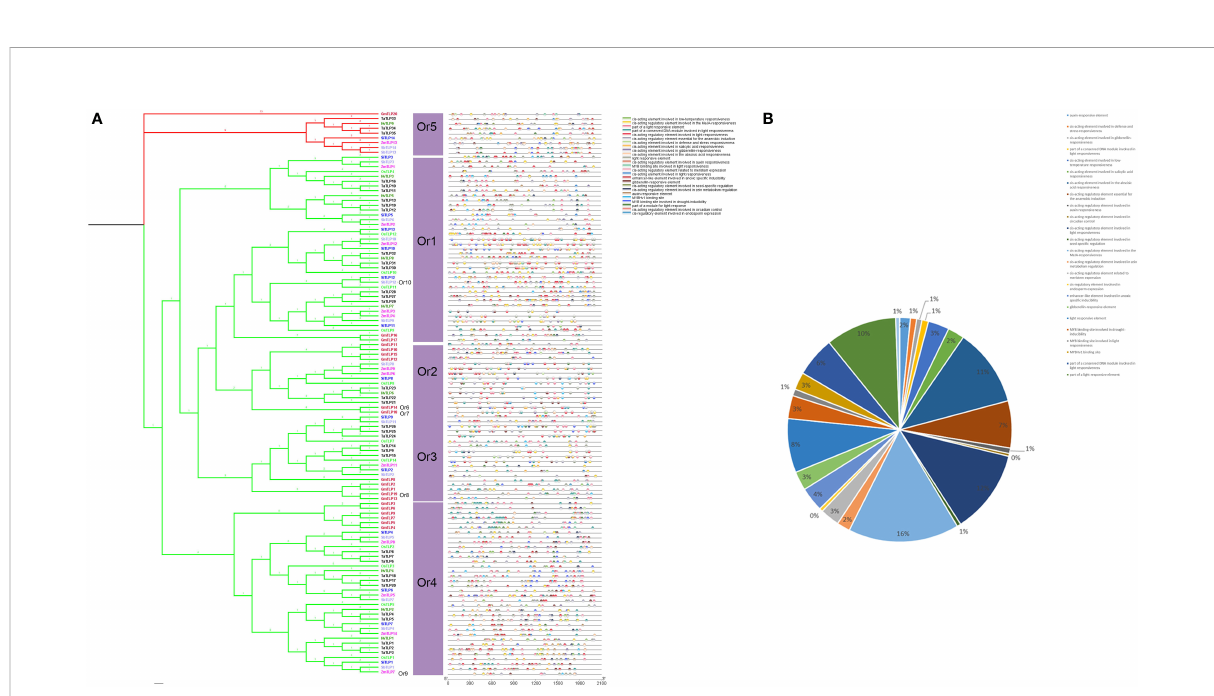
FIGURE 6 Cis-Acting elements in the promoter of TLP genes. (A) Cis-Acting elements of TLP genes were marked by different color box (B) The percent of different promoter element were shown by pie